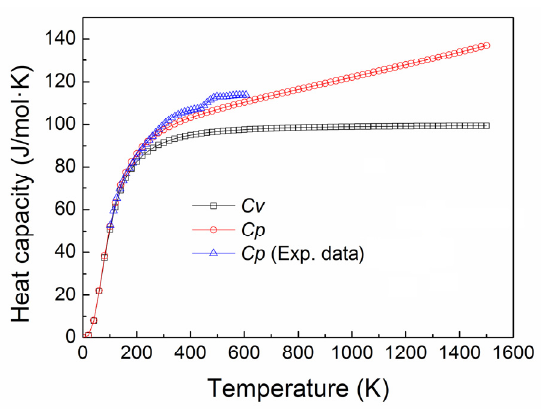
Figure 8. The specific heats at constant pressure ( C p ) or volume ( C p ) of AlNi 2 Ti as a function of temperature [92].